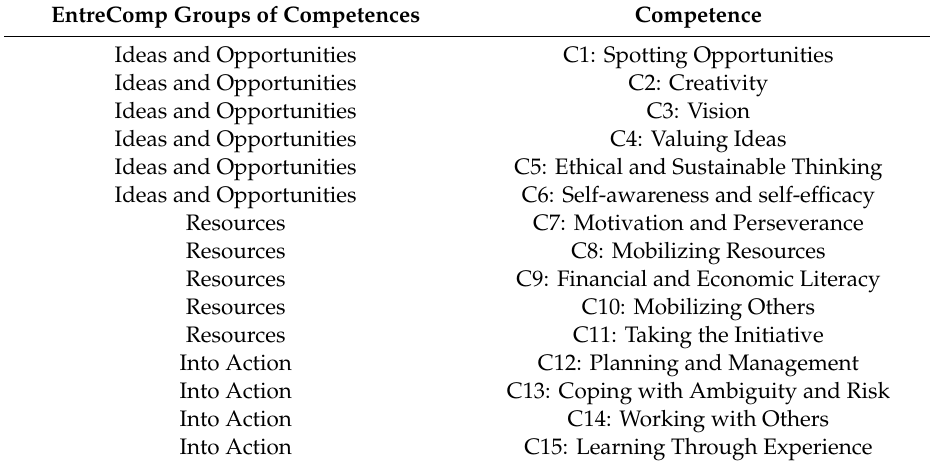
Table 1. EntreComp competences framework (adapted EntreComp visual model by